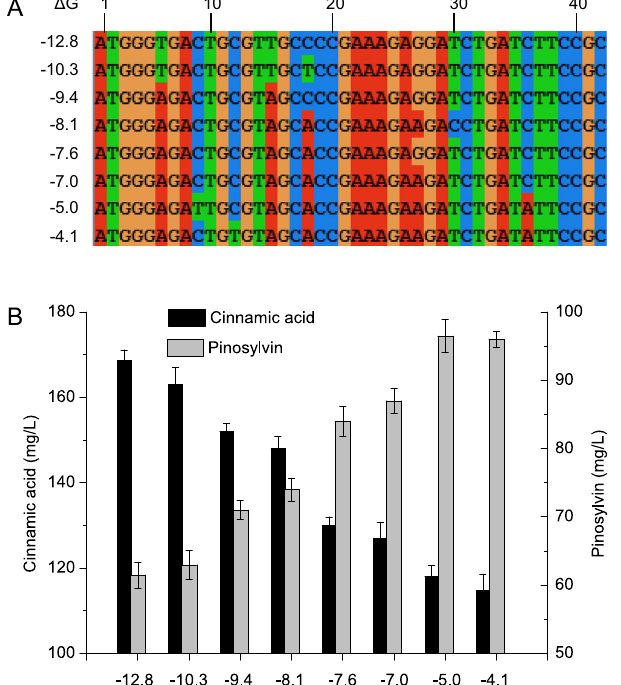
Figure 5. The effect of reducing 5 ′ region of 4CL mRNA secondary structure on pinosylvin production. ( A ) The alignment of different 4CL variant sequences ( + 1 to + 42). ( B ) Effects of differences in 4CL variant on pinosylvin and cinnamic acid concentrations. Numbers such as − 12.8, − 10.3 denoted Δ G of 5 ′ region of 4CL mRNA secondary structure. Δ G of original 4CL was − 12.8 kcal/mol.